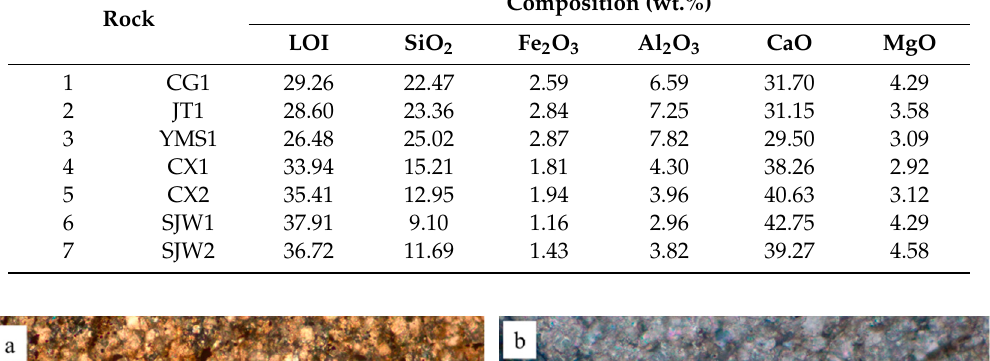
Figure 3. The XRD pattern of self-made cement clinker. 2.2. Preparation of Concrete Microbars and Rock Prisms The modified concrete microbars (4 cm × 4 cm × 16 cm) were prepared with self-made cement and dolomitic rocks of 5–10 mm in grain size according to RILEM AAR-5 [22]. The weight ratio of aggregates to cement was fixed to 1/1 and the water-to-cement ratio was 0.32. In addition, 900 g of cement was used for each batch for three concrete bars. For each microbar formulation, aggregates and cement were mixed in a mixer (Type NJ-160A, Luheng Co., Ltd., Shanghai, China). All specimens with the mold were placed in a moist environment (RH = 98%) at 20 °C. After 24 h, the specimens were taken from the molds. Then, the initial length measurement was taken and the bars were transferred to containers filled with TMAH solutions. Rock prisms were prepared according to ASTM-C586 [24]. Rocks were modified by a cutting machine to obtain prism rocks with of 4 cm in length, 1 cm in width, and 1 cm in height. Nails were fixed at both ends of the rock prisms by glue and cement. Prepared rock prisms were cured in a 1-mol/L TMAH solution at 80 °C. After all specimens were cured to the corresponding age, the expansion rate test and calculations were performed, and the curing solution was changed every 14 days. The formulas for calculating the 10